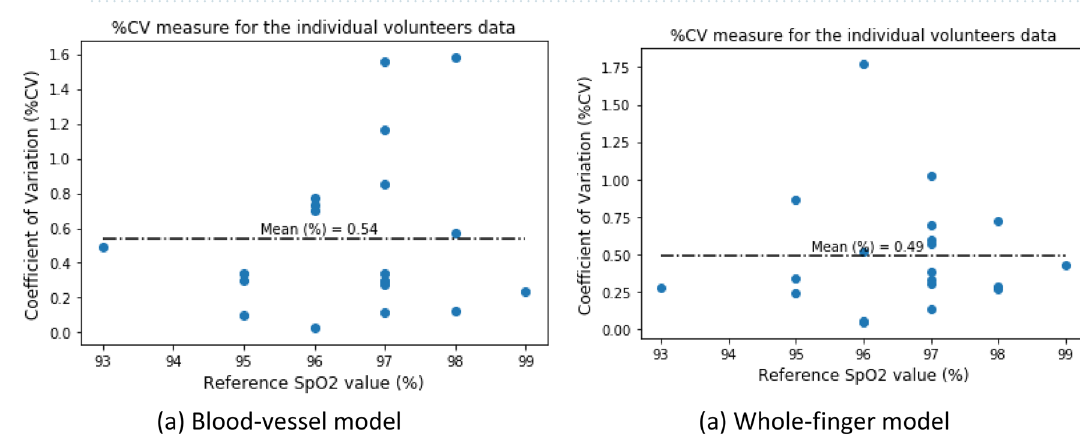
Figure 15. Percent coefficient of variation for the reference and estimated %SpO 2 values for both